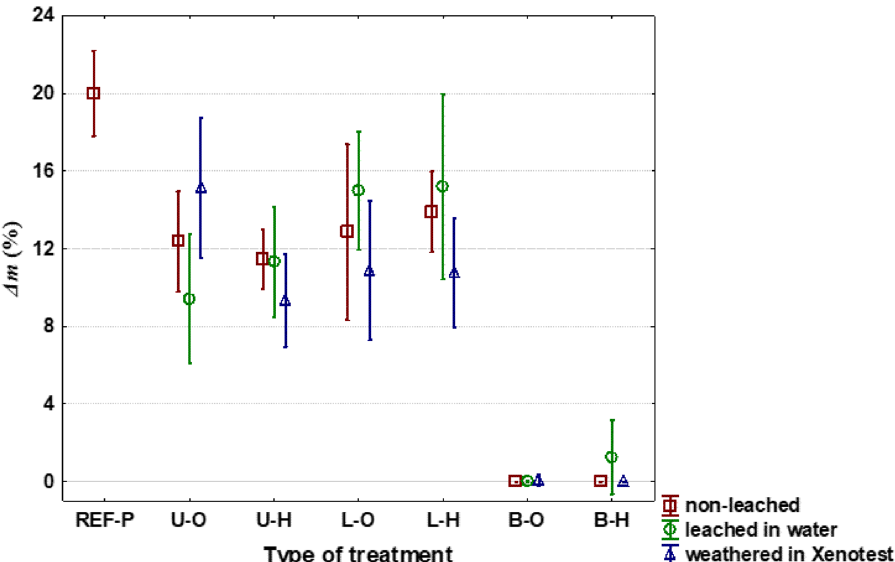
Figure 3. Mass losses (Δm) of wood caused with the brown-rot fungus Rhodonia placenta after 16-weeks. Reference—the Scotch pine wood—(REF-P); Other symbols are valid for the Norway spruce wood: Untreated original—(U–O); Untreated, but with the additional hydrophobic substance—(U-H); Treated with the lavender oil—(L-O); Treated with the lavender oil and then with the hydrophobic substance (L-H); Treated with the Bochemit QB—(B-O); Treated with the Bochemit QB and then with the hydrophobic